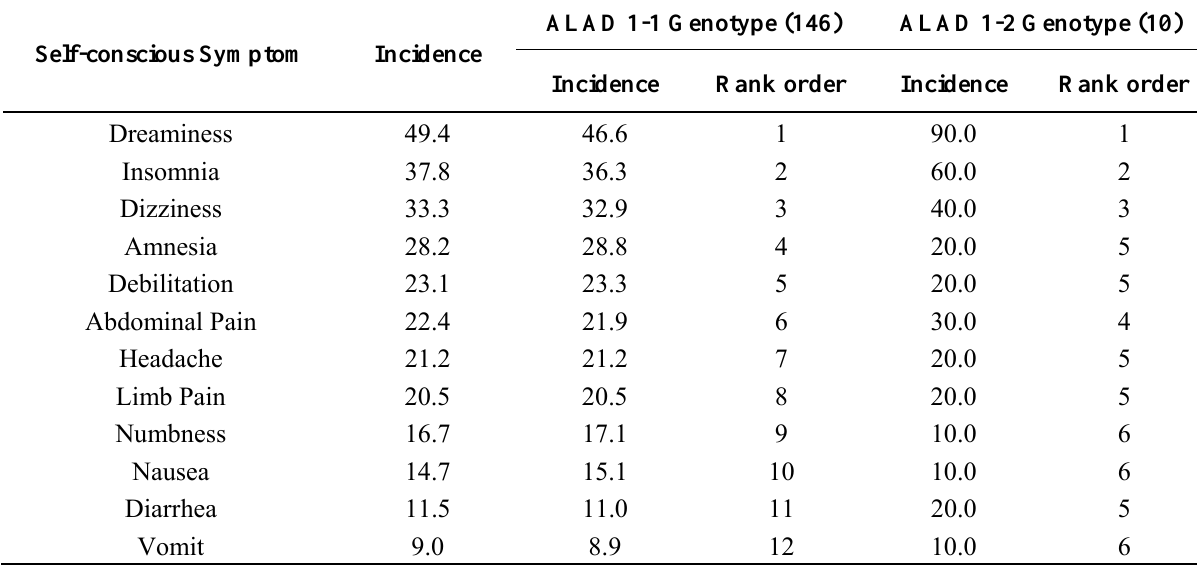
Table 2. Self-conscious symptom incidence and rank order with different ALAD genotypes (%). ALAD 1-1 Genotype (146) ALAD 1-2 Genotype (10) Self-conscious Symptom Incidence Incidence Rank order Incidence